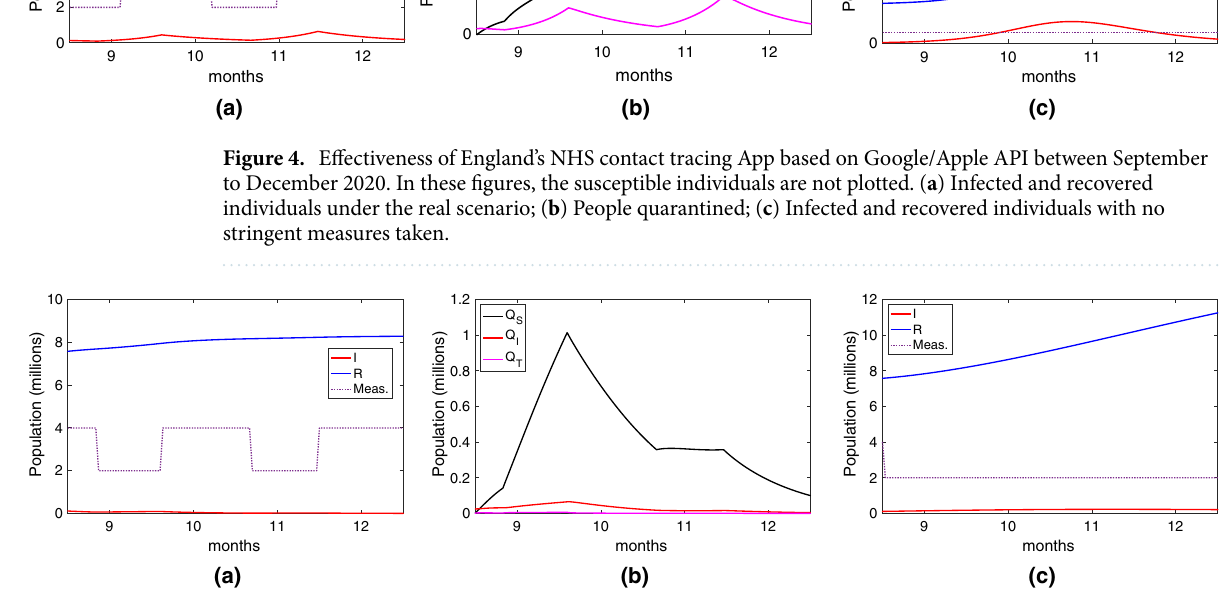
Figure 5. Effectiveness of the Chinese/Korean tracing applications between Sep-Dic 2020. In these figures, the susceptible individuals are not plotted. ( a ) Infected and recovered individuals under the real scenario; ( b ) People quarantined; ( c ) Infected and recovered individuals with no stringent measures